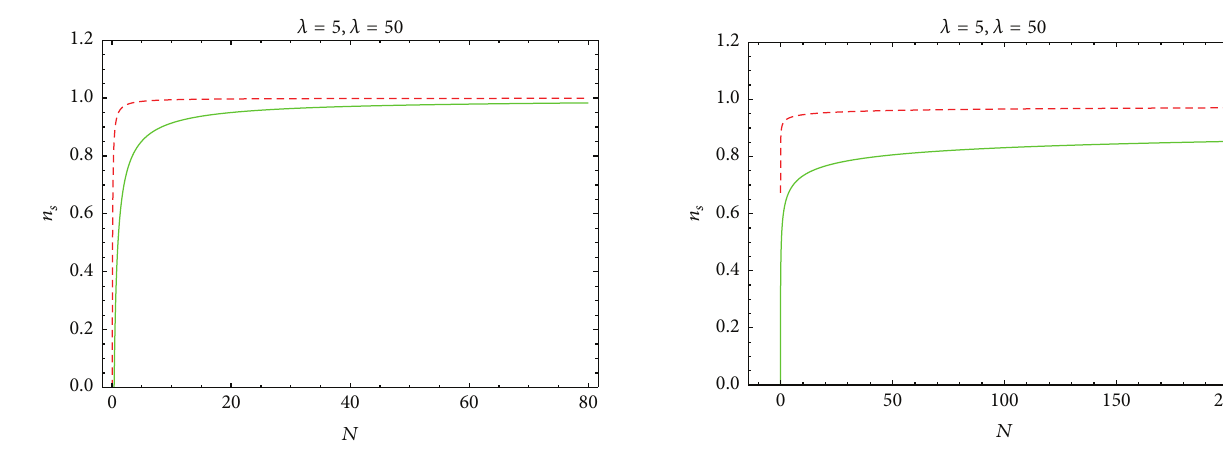
Figure 8: Spectral index in terms of number of e-folds, ] = 50 by dashed line and ] = 5 by green line.